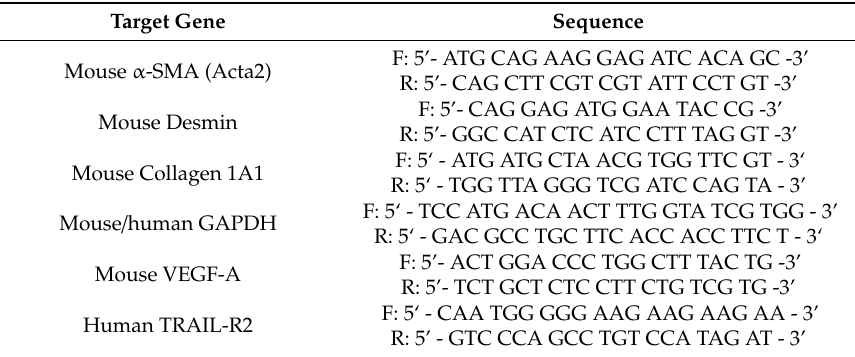
Table 1. Primer sequences used for qRT-PCR.